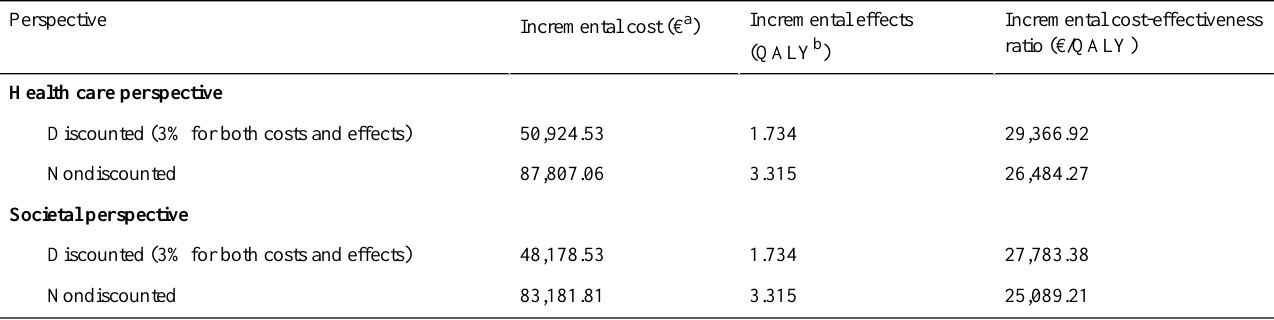
Table 3. Incremental costs, effects, and cost-effectiveness ratio from health care and societal